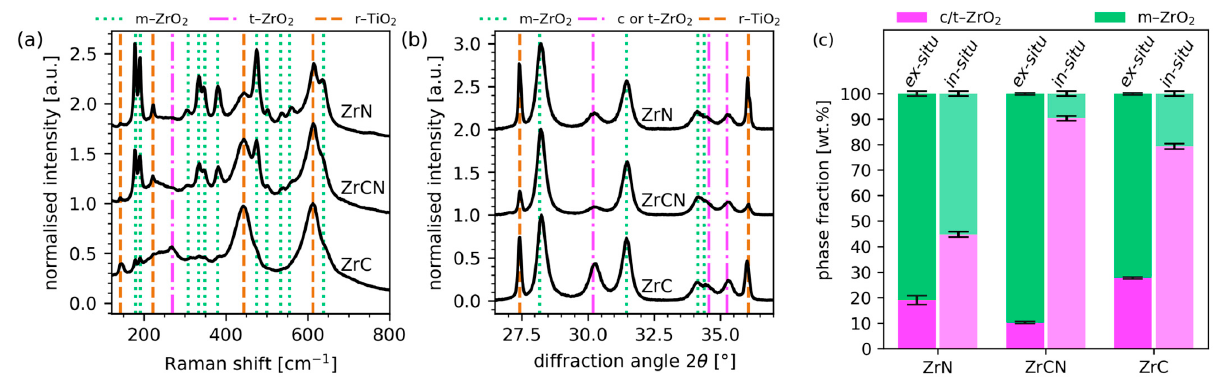
Figure 7. ( a ) Ex-situ Raman spectra and ( b ) ex-situ X-ray diffractograms of the ZrN, ZrCN and ZrC powdered samples oxidised at 1000 ◦ C. ( c ) Phase fraction of the ZrN, ZrCN and ZrC samples oxidised at 1000 ◦ C, measured ex-situ using a laboratory XRD at room temperature and in-situ at the synchrotron facility at 1000 ◦